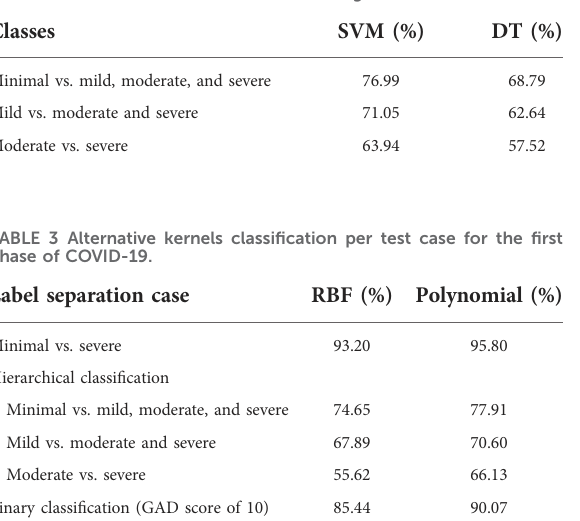
TABLE 2 Hierarchical classi fi cation according to class.